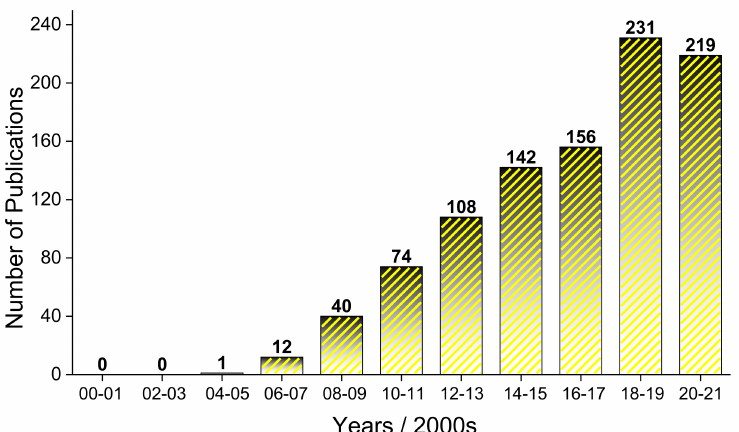
Figure 4. Number of researches related to the catalytic processes for biodiesel production since 2000. The search was made on 18 June 2021, over the database Scopus and were found a total of 983 articles for this